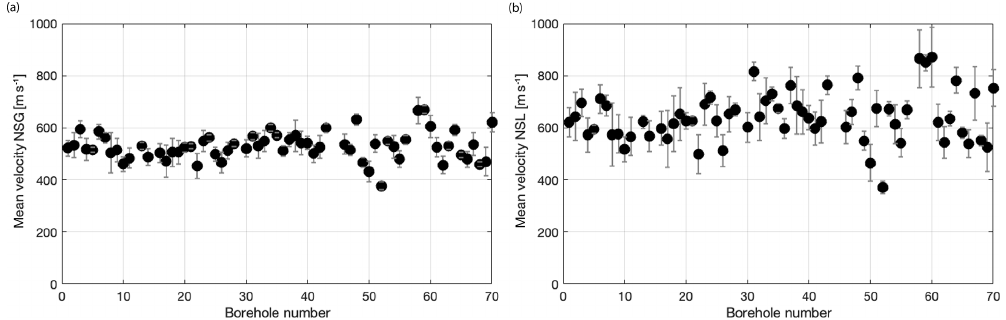
Figure 8. (a) Average shear-wave velocities (black dots) and standard deviation (grey bars) derived from the H / V ratio of five teleseismic events, sorted by station number for (a) V NSG s and (b) V NSL s .